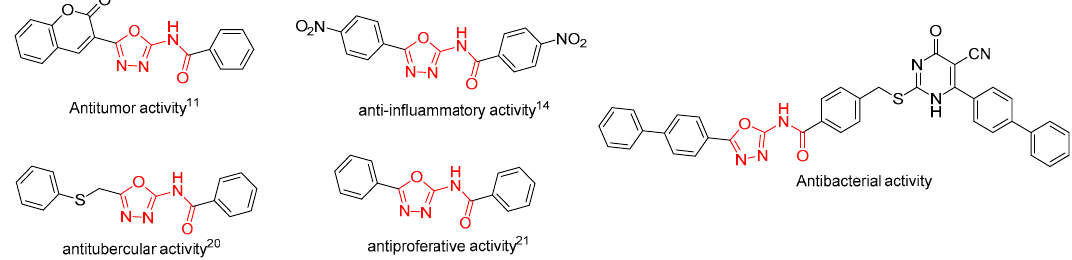
Figure 1. Biologically active compounds containing the 2-acylamino-1,3,4-oxadiazole core motif.